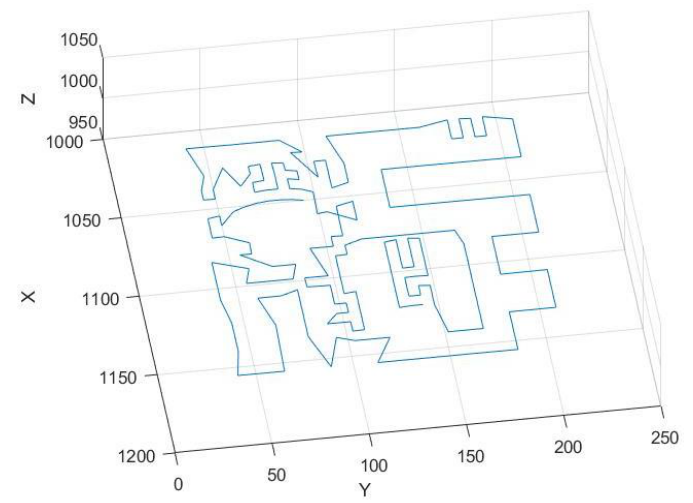
Figure 8. Path generated by the method proposed in this paper.